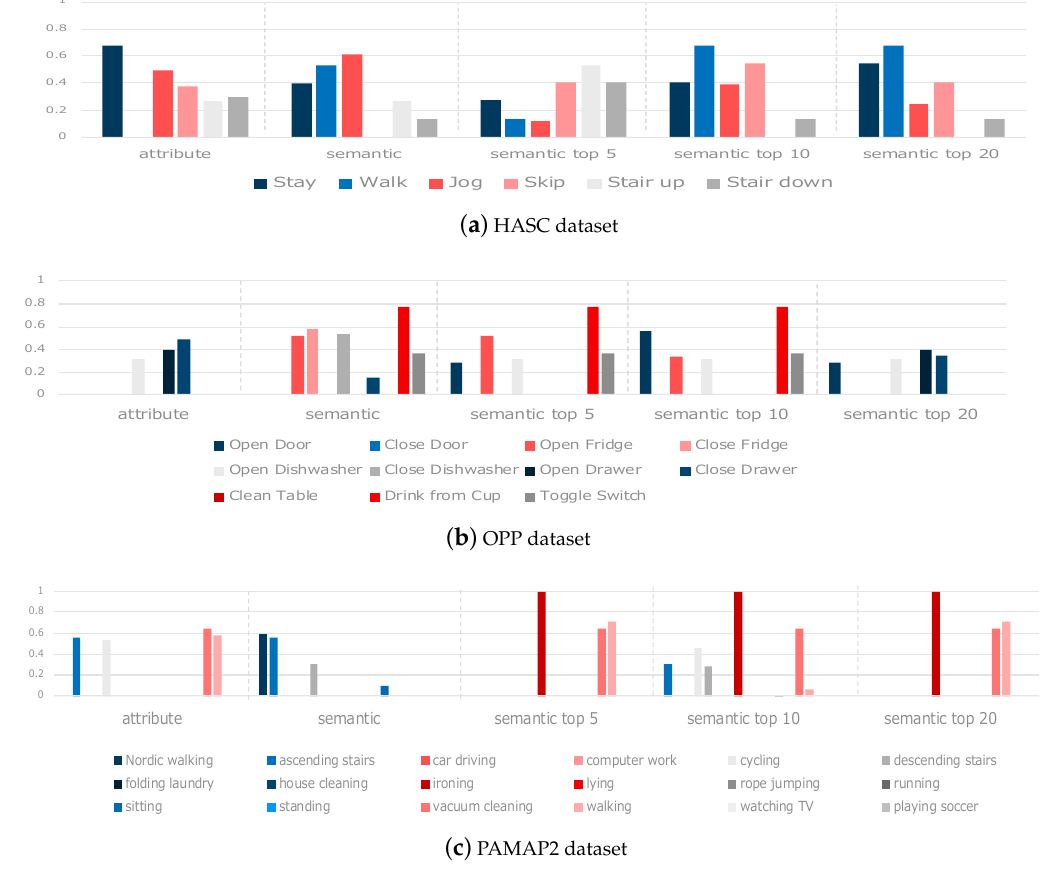
Figure 3. Average F-score of estimation for unknown activity